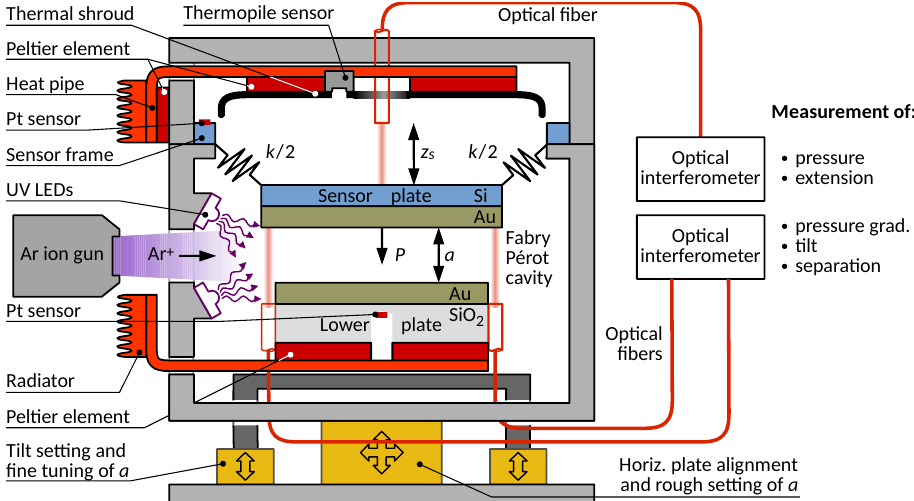
Figure 1. Simplified schematic representation of the C ANNEX core setup showing the fiber-optic detection mechanism, major mechanical components, and parts of the thermal control system. Note that the real setup has a 120 ◦ symmetry in most parts. In this two-dimensional representation, a partial 180 ◦ symmetry is depicted